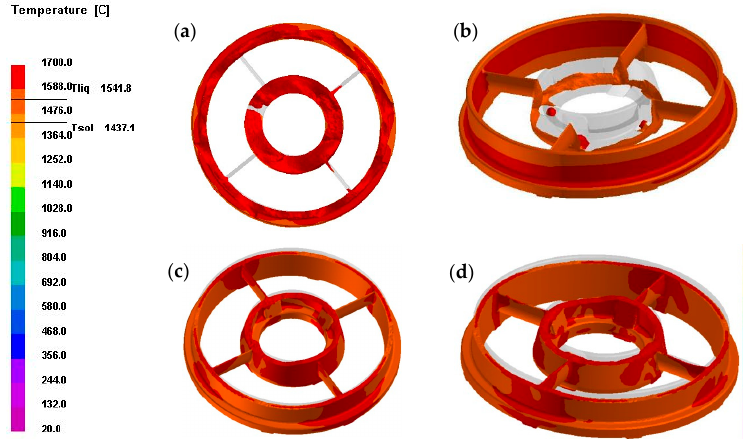
Figure 3. Temperature field of melt-filling in the gravity field. The melt liquid was filled horizontally upwards from the bottom runner under the effect of the gravitational field. The whole melt-filling process was relatively smooth. ( a ) the metal fluid in the support plate area came mainly from the outer ring; ( b )The melt liquid in the four support plates nearly filled from the outer ring into the support plates; ( c , d ) the super-heat areas in the outer ring were located near the inner-gate.